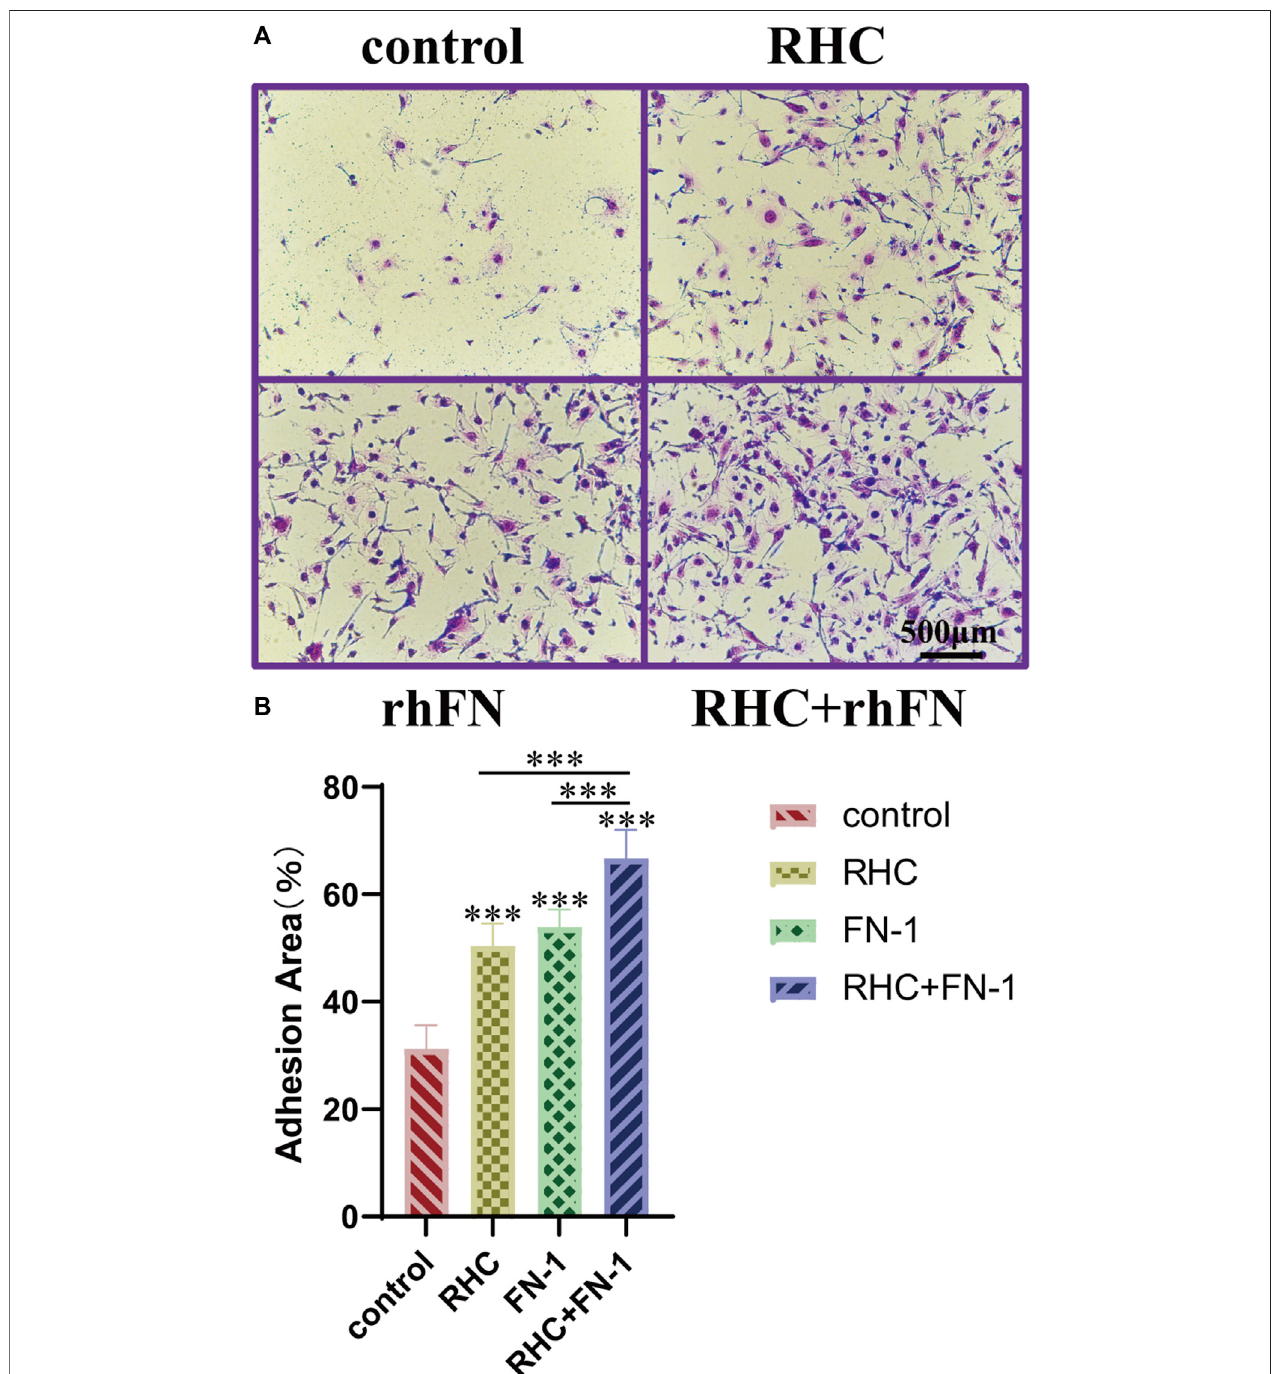
FIGURE5| TheeffectofRHC+rhFNonadhesionwithFCs. (A) CrystalvioletstainingimagesofFCsathour4.Scalebar=500 μ m. (B) Calculationandcomparison of adhesion area at hour 4. Data are presented as the mean ± SD ( n = 6). Statistical analysis: ppp p < 0.001.